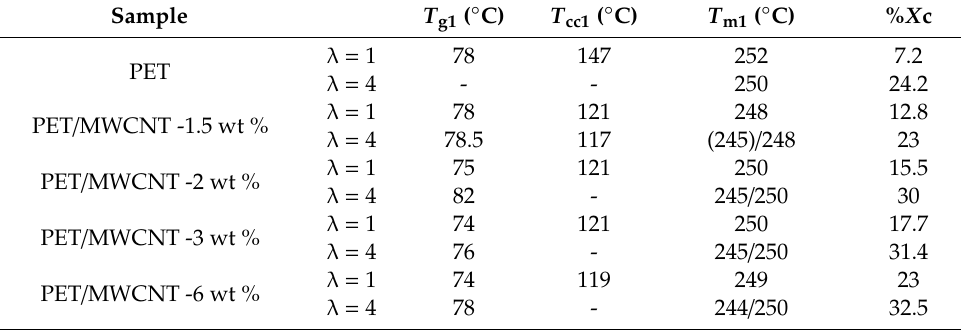
Figure 5. DSC thermograms for unstretched and stretched neat PET and PET/MWCNT composites films. The results presented correspond to the first heating cycle, where the information refers to the actual state of the polymer crystals. Table 2. Effect of stretching on thermal parameters for PET and PET/MWCNTs composites. Subscript 1 indicates the first heating cycle.